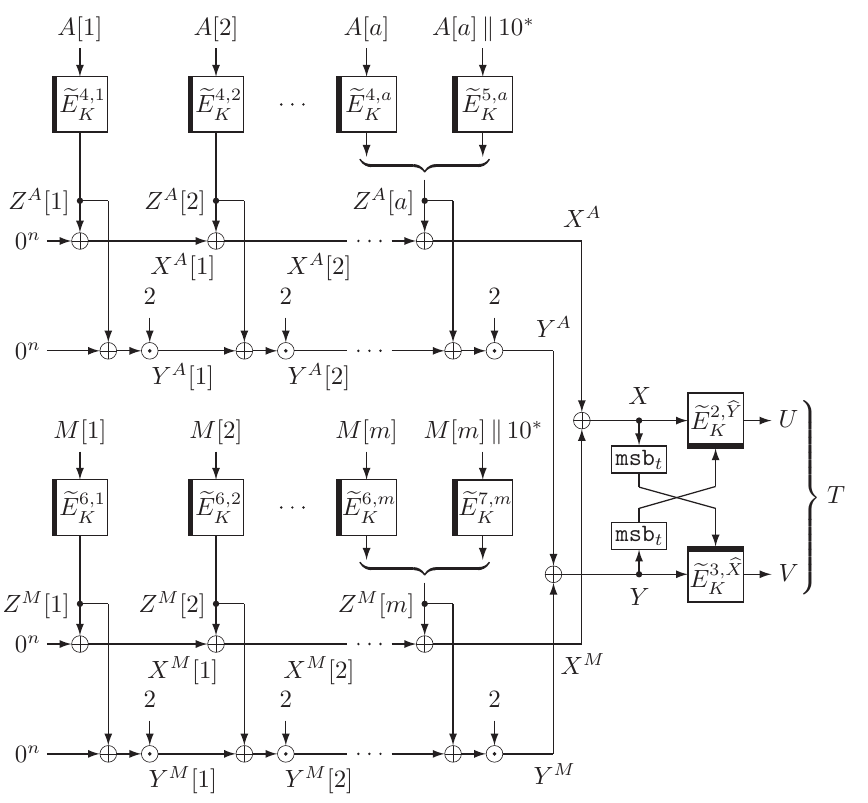
Figure 7: vPMAC2x, the PRF of